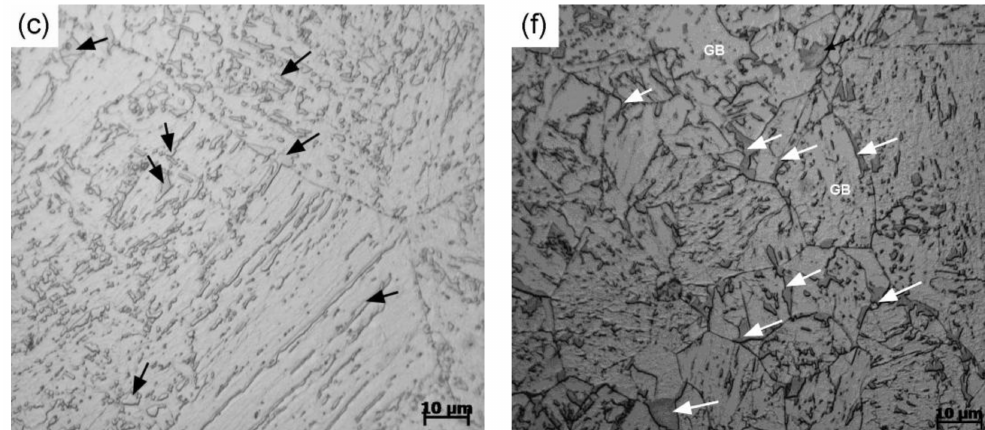
Figure 3. Optical microstructure with different peak temperatures: ( a – c ) 1350 ◦ C and ( d – f ) 1100 ◦ C, and different cooling times: t 8/5 ( a , d ) 5 s, ( b , e ) 85 s, and ( c , f ) 600 s. (LM: lath martensite, BF: bainitic ferrite, GB: granular ferrite, and some martensite–austenite (MA) constituents were signified with